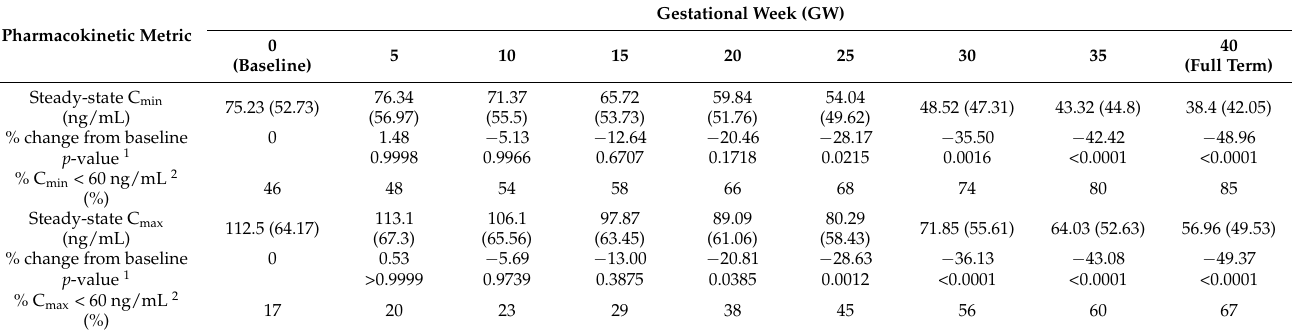
Table 4. Predicted fluvoxamine plasma-concentration across the maternity period.